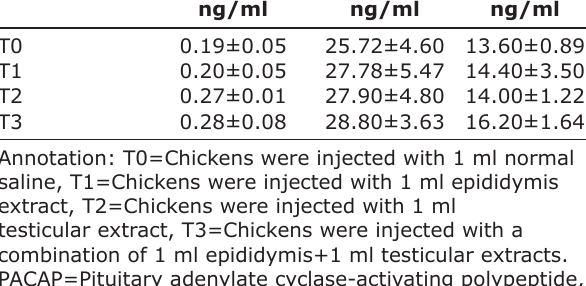
Table-1: The concentration of testosterone, PACAP, and PRM1 (mean±standard deviation) after injected with epididymis and testicular extracts and their combination in male chicken.